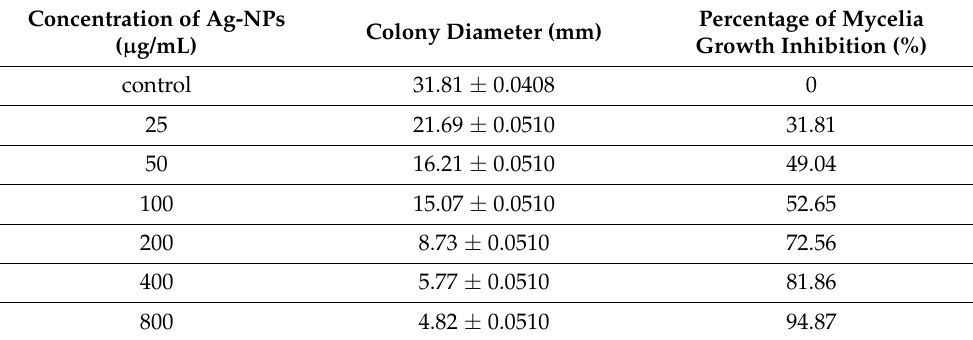
Table 1. Inhibitory effects of Ag-NPs on P. litchi growth.